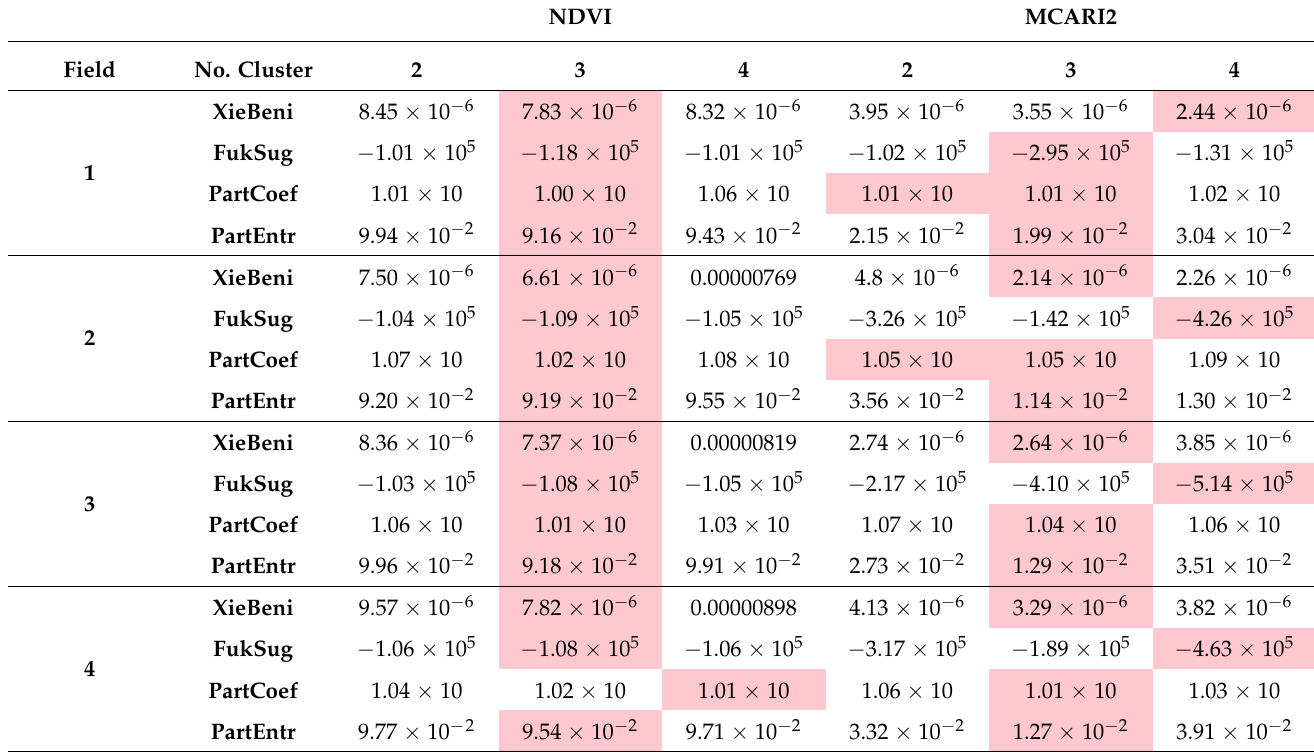
Table 7. Indices used to select the number of clusters from fuzzy k-means cluster results for 10 durum wheat fields, in Italy. For each index, the optimum class number among 2, 3, or 4 classes is suggested by the lowest index value, with a red